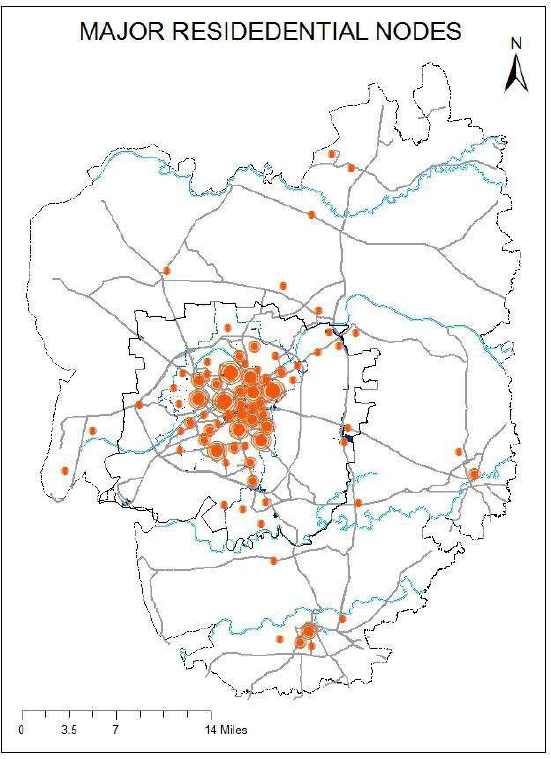
Figure 3: Nodes with Population> 1000 (Surat) By development of these regional nodes, metro alignment can be developed on a regional scale essentially connecting these Nodes. From the property tax data obtained from Surat governing land use of the area